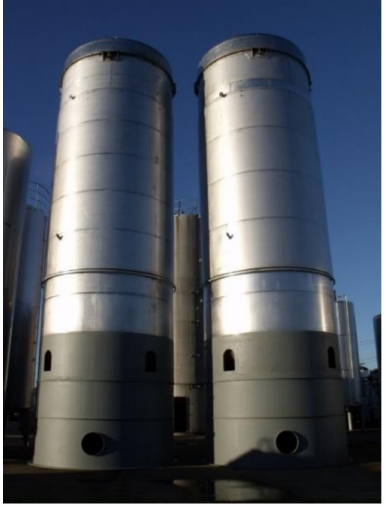
Figure 5. Cylindroconical batch fermenters